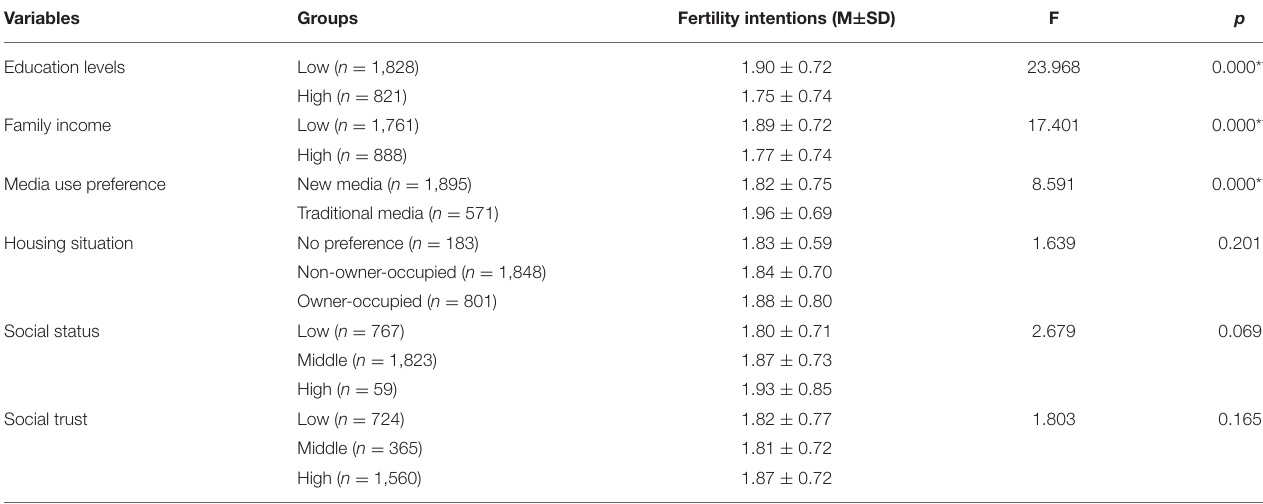
TABLE 3 | Differences in fertility intentions of reproductive-aged women from the different variables.